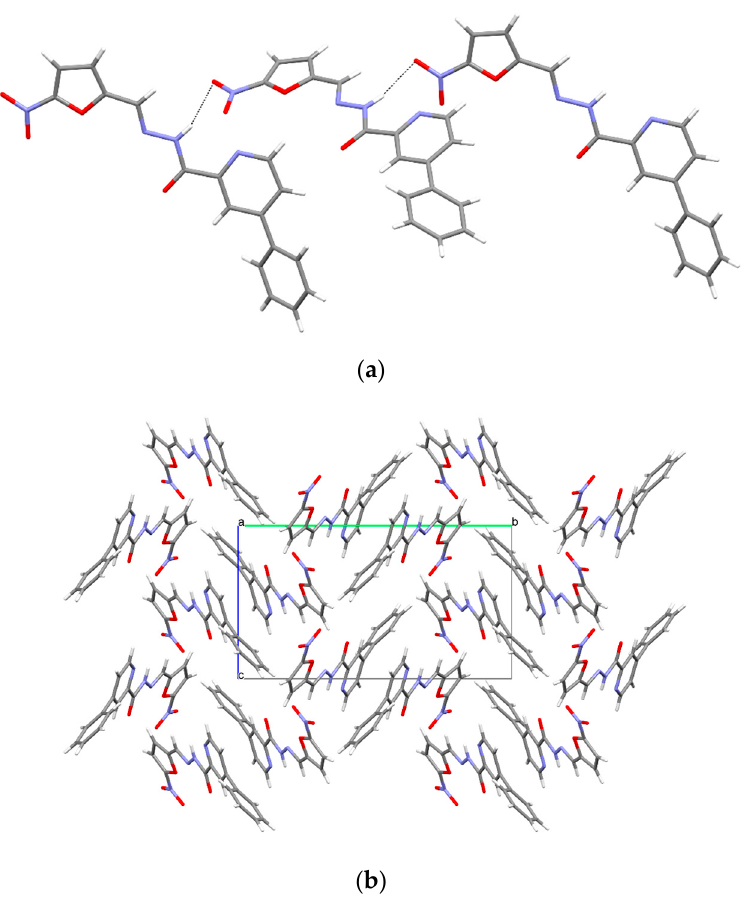
Figure 9. ( a ) Intermolecular hydrogen bonds in 4a . ( b ) The packing of molecules in 4a (a, b, c–unit cell).